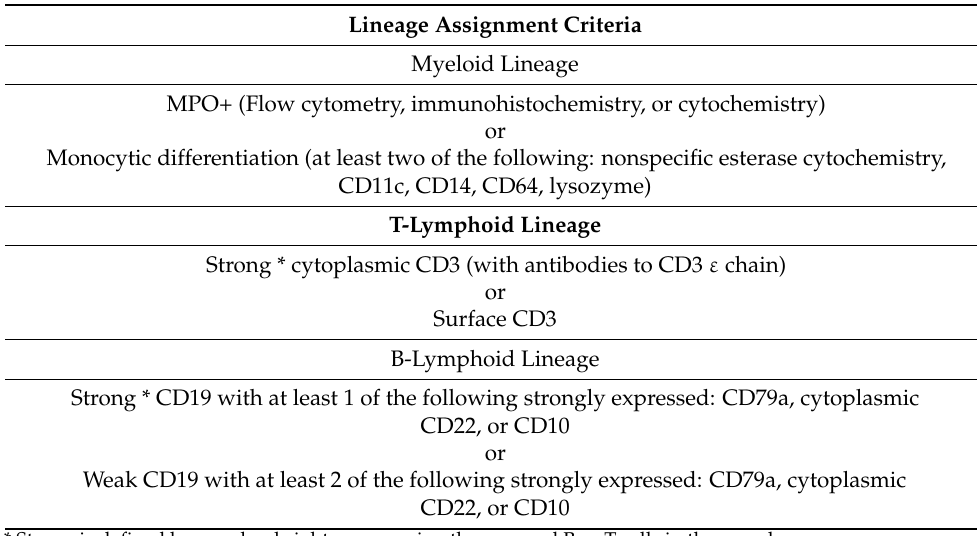
Table 1. Criteria for lineage assignment in mixed phenotypic acute leukemia.